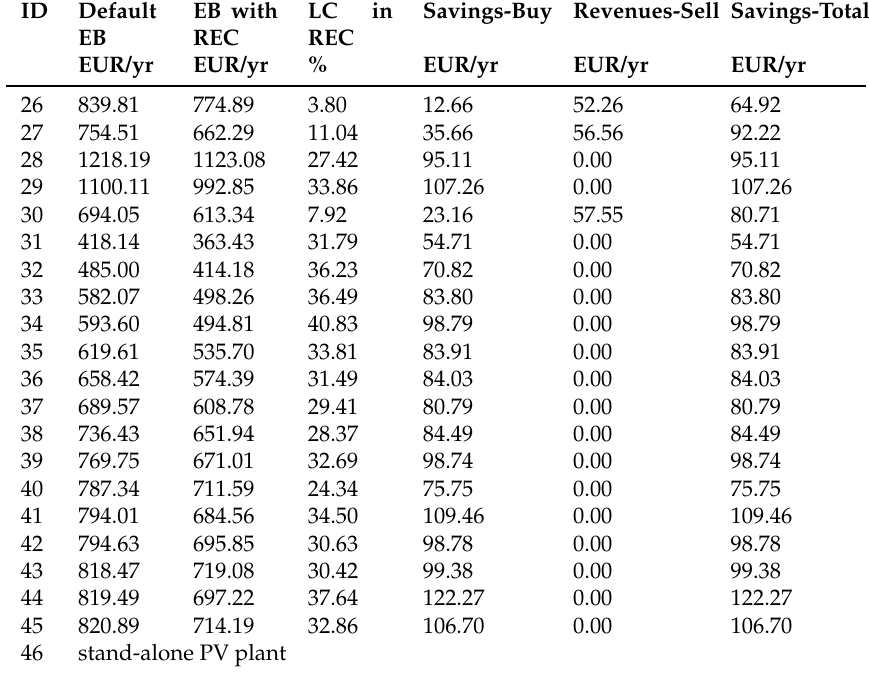
Table 9. REC of residential customers and a stand-alone PV plant: Results for customers 26–45. Detailed explanation of the individual columns given in Table 5. Note, that revenues due to selling electricity within the community are zero for MAB residents 31–45 despite the availability of an in-house PV system, because the PV system is